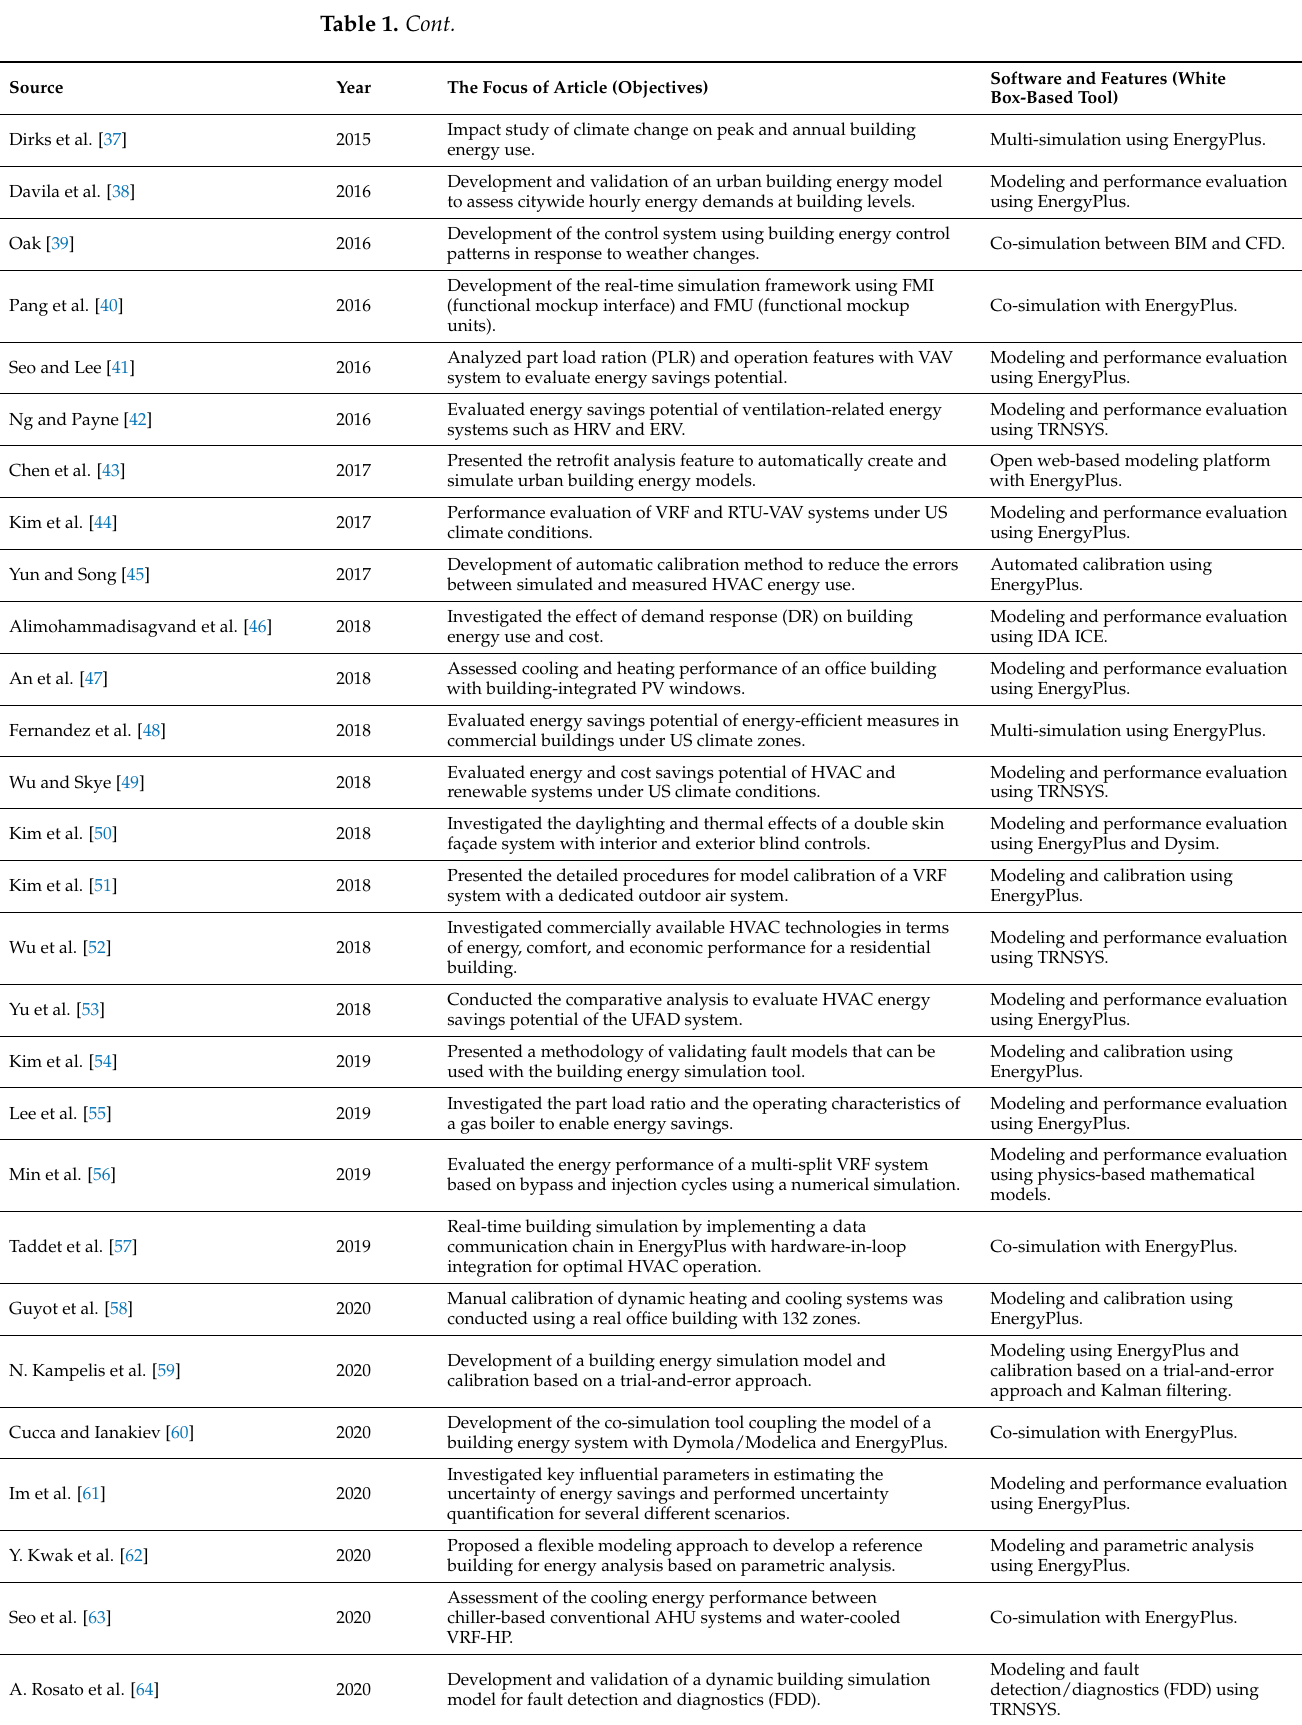
Software and Features (White Box-Based Tool) Modeling and performance evaluation using EnergyPlus. Co-simulation with EnergyPlus. Modeling and performance evaluation using EnergyPlus. Modeling and performance evaluation using